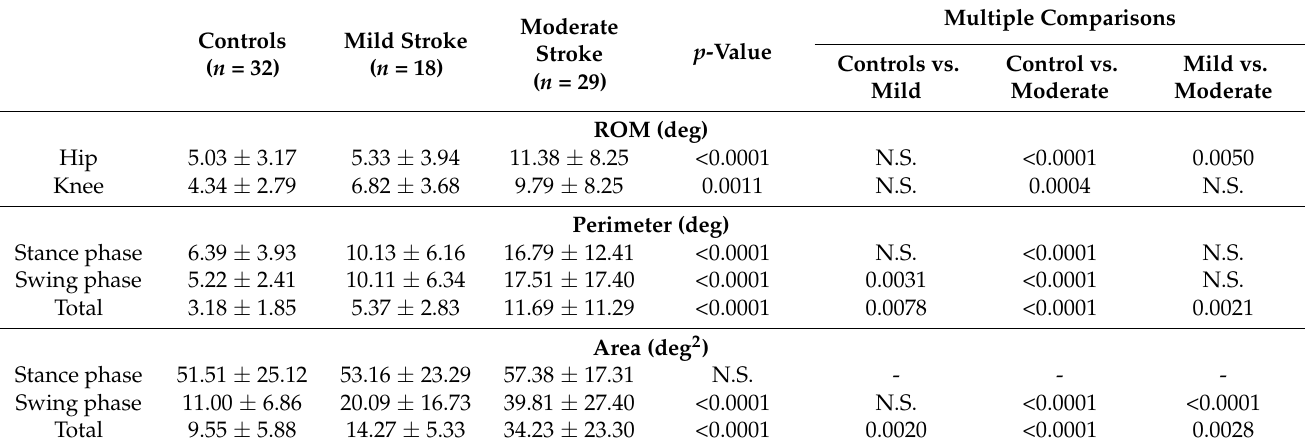
Table 3. The coefficient of variance (CV) for hip-knee cyclogram parameters. The results are presented as mean ± standard deviation, or n . p -values were calculated by Kruskal–Wallis tests. Multiple comparisons between groups were calculated by Mann–Whitney U-tests with Bonferroni